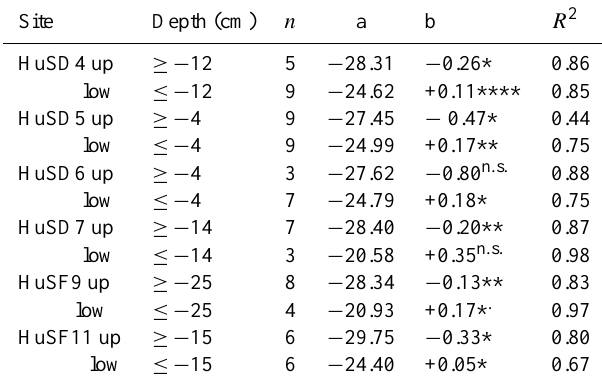
Regression coefficients for the linear function depth = a+b · δ 13 C in the investigated hummocks. up = above and low = below the turning